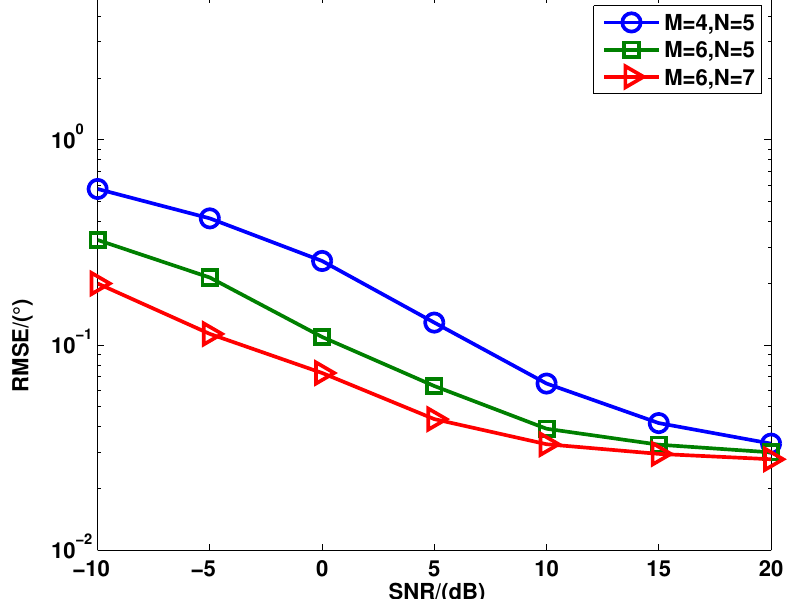
Figure 7. RMSE of the proposed method versus different elements when the SNR varies from − 10 dB to 20 dB. Table 1. Computation time comparison of l uncorrelated targets when the targets number varies from 3 to